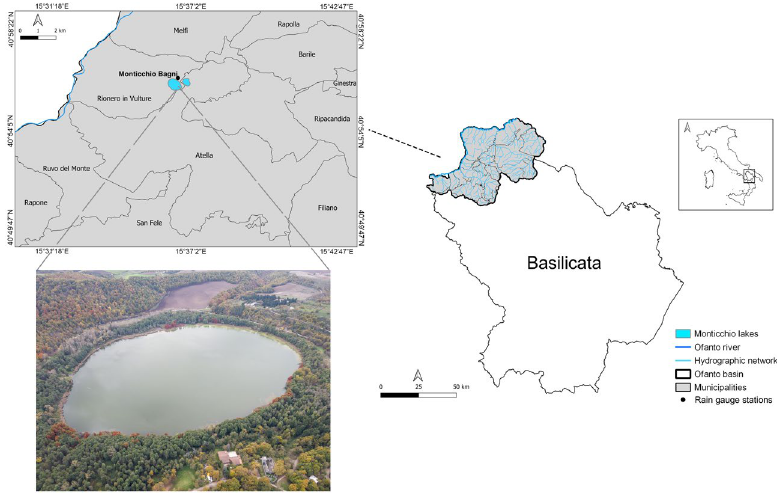
Figure 1. Lucanian Ofanto basin and aerial photo of Lago Grande.